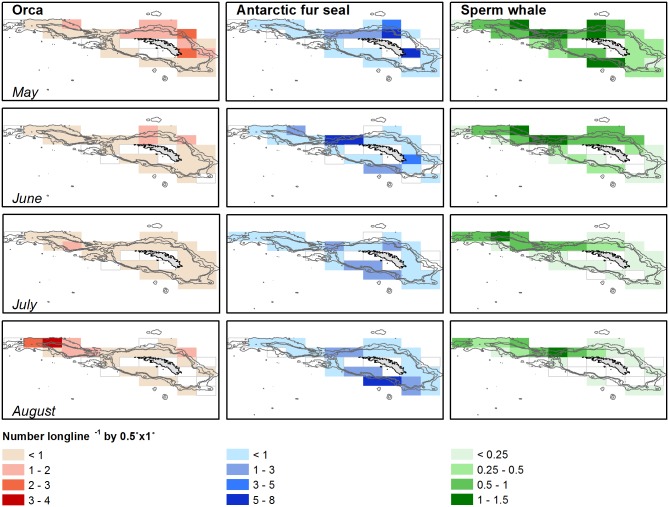
Mammal movements over the winter season.Observations per unit effort (animals/longline/box) of orcas, fur seals and sperm whales around South Georgia throughout the winter season.